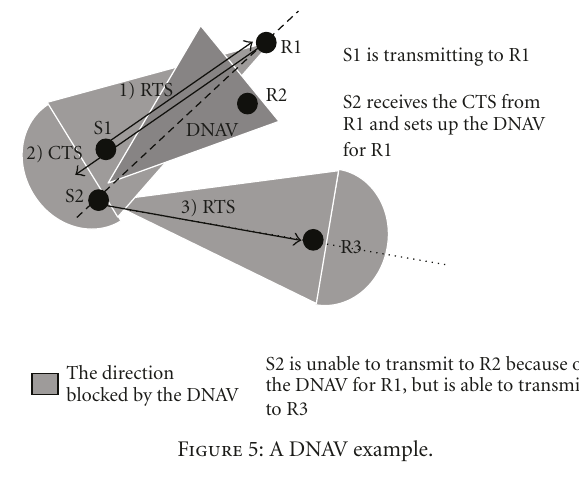
Figure 5: A DNAV